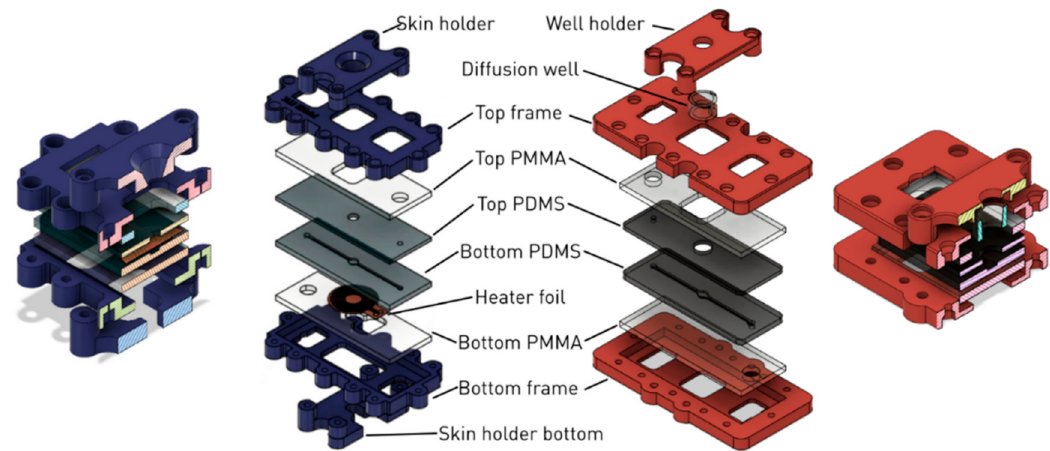
Figure 4. Exploded schematic view of the Microfluidic Diffusion Chamber (MDC) generations. Left (blue): Cross-sectional and layer-by-layer view of the first-generation temperature-controlled device with the skin sample holder. Right (red): Layer-by-layer and cross-sectional view of the second-generation device with a diffusion well